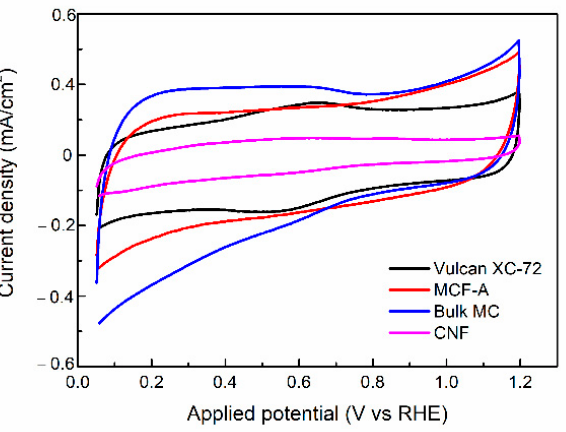
Figure 5. Cyclic voltammograms (CVs) of MCF-A, bulk MC, Vulcan ® XC-72, and carbon nanofibers (CNFs) obtained in N 2 -saturated HClO 4